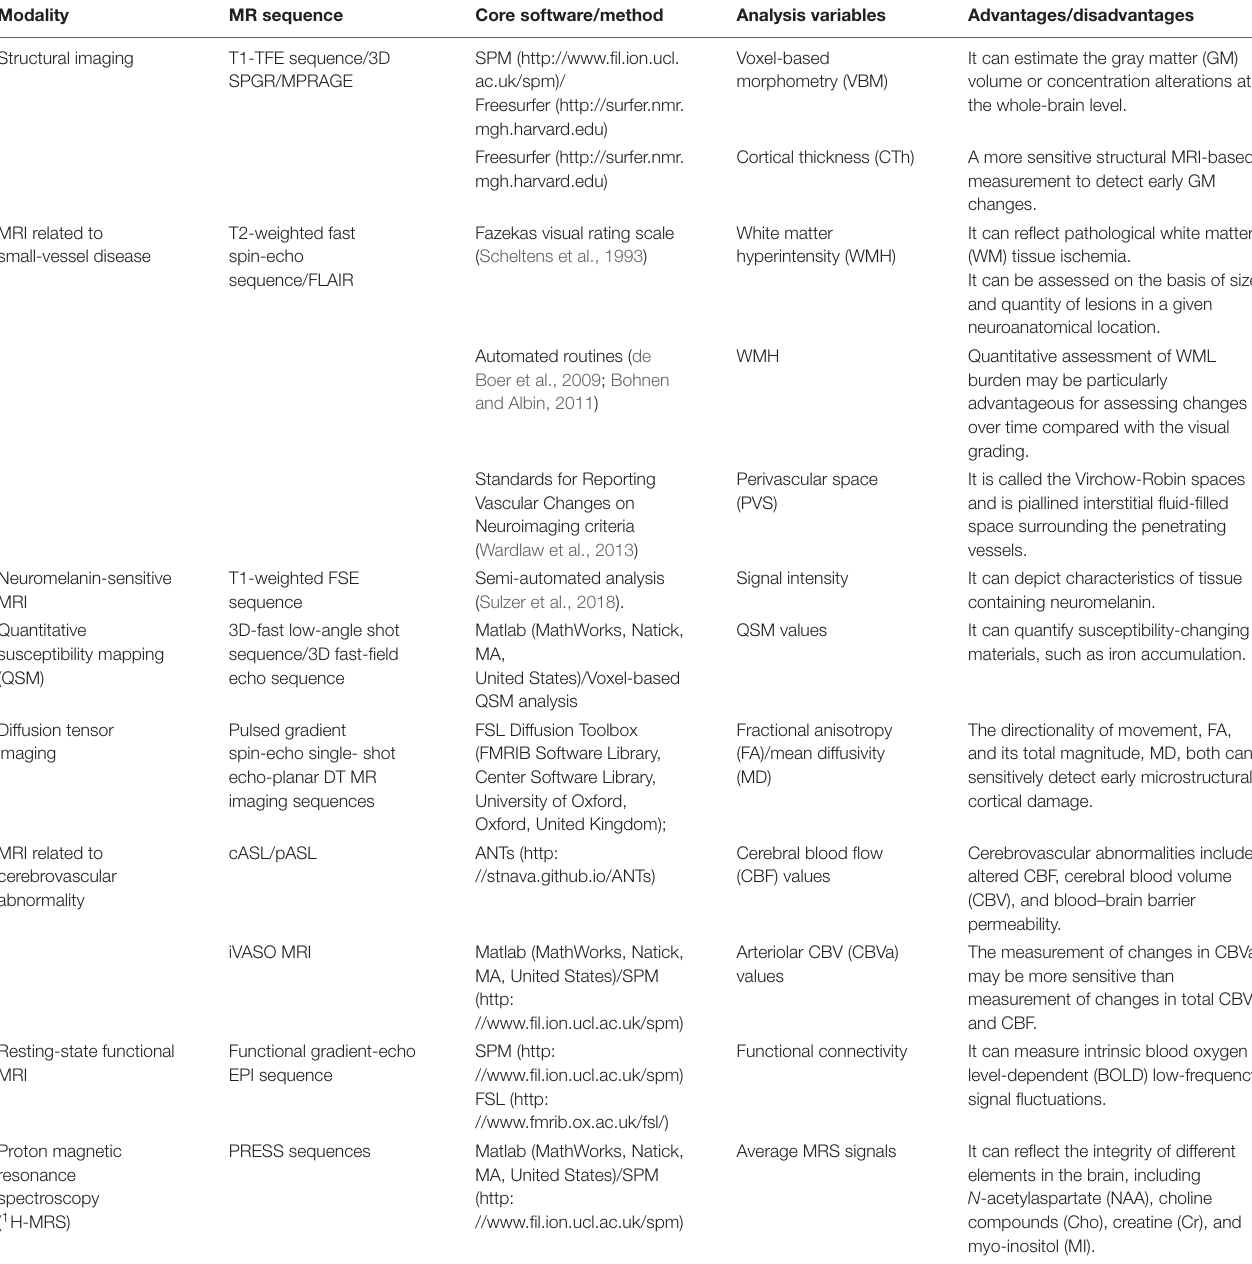
TABLE 1 | Imaging characteristics of magnetic resonance imaging studies in Parkinson’s disease and cognitive